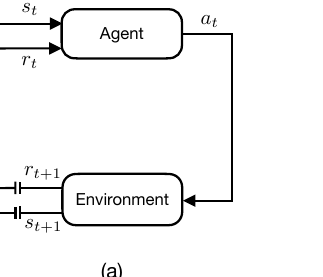
Figure 5: Locality of interaction in multi-agent systems with time-varying spatially distributed interest- points. (a) Recursive state space decomposition. The planning problem for subregion 1 is conditionally independent of subregions 2, 3 and 4 because these regions have approximately the same density of interest-points and agents. Similarly, the planning problem for their union is conditionally independent of regions 5-7. (b) Temporal/hierarchical task space decomposition. Primitive actions move agents within each subregion. Macro-actions move agents between subregions. Higher level macro-actions move agents between larger “macro” regions.